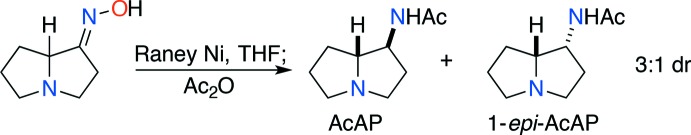
Synthesis of AcAP.